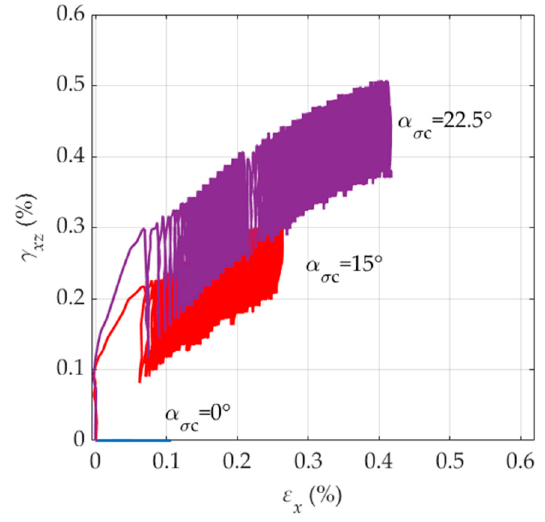
Figure 13. Relationship between torsional strain and axial strain for all three tests.